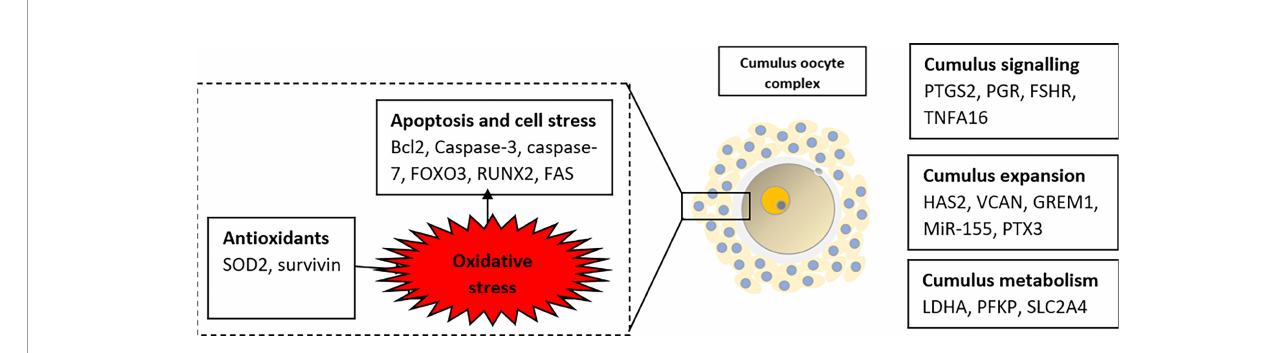
FIGURE 3 | Summary of selected potential genes related to embryo viability in human cumulus